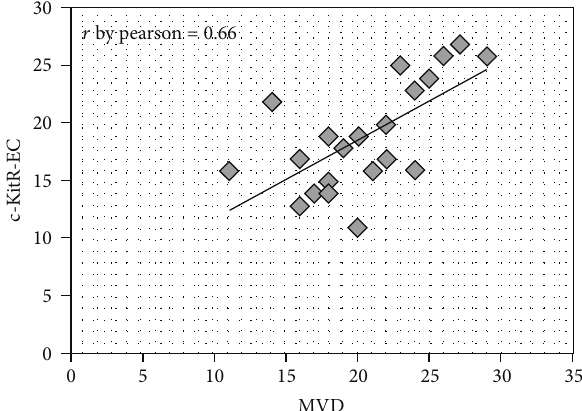
Figure 3: Pearson distribution of correlation between c-KitR-EC and MVD 𝑟 = 0.66